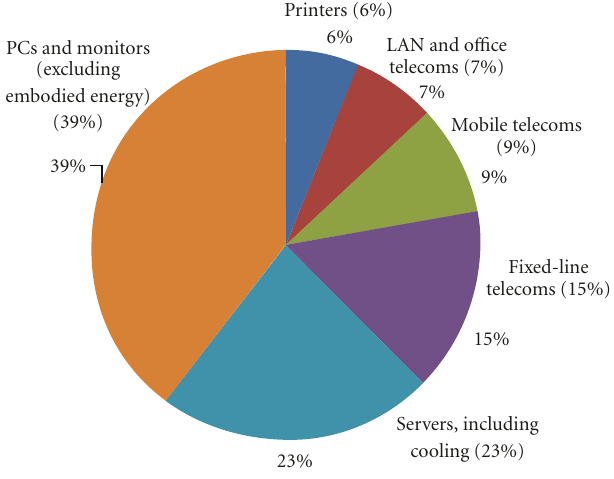
Figure 1: Power usage of ICT